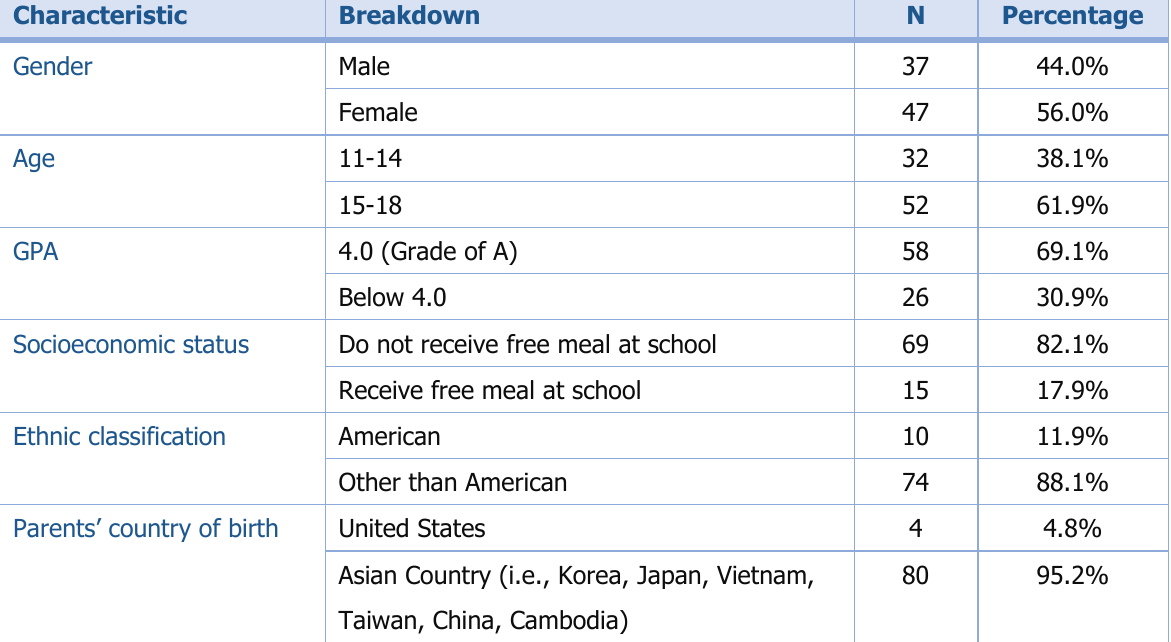
Table 1. Characteristics of the Study Participants, N =